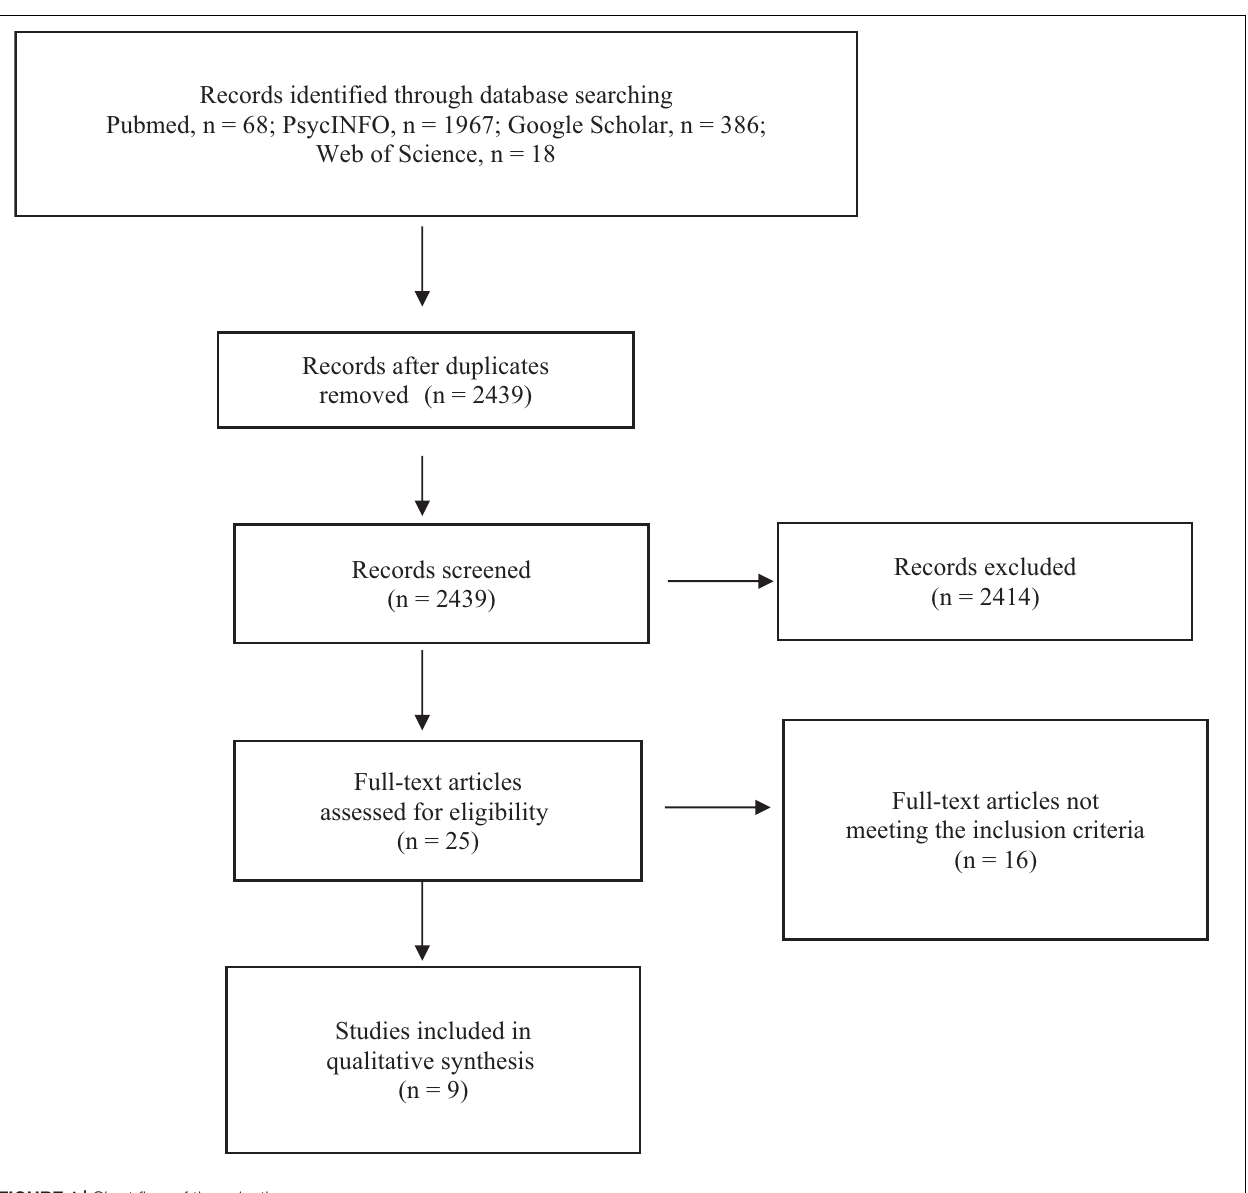
FIGURE 1 | Chart flow of the selection